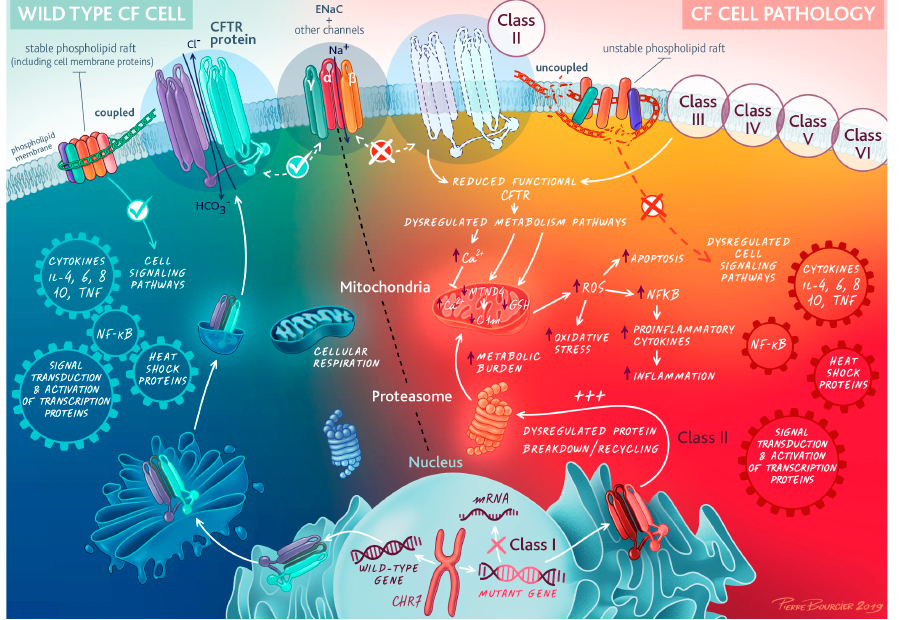
Figure 2. Cell biology of cystic fibrosis transmembrane regulator (CFTR). Abnormal CFTR and signaling pathways at the epithelial cell membrane. Mutation classes are discussed in depth in Section 3. Reprinted/adapted with permission from © ERS 2023: European Respiratory Journal May 2020, 55 (5) 1902443; DOI: 10.1183/13993003.02443-2019. Copyright and Licensing are available via the following link: https://www.mdpi.com/ethics#10.